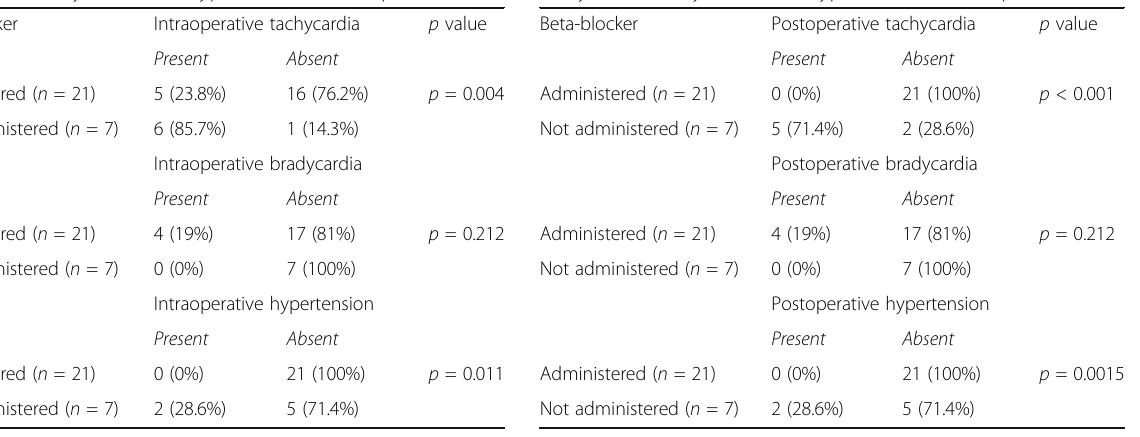
Table 3 Relation of use of beta-blocker with intraoperative tachycardia, bradycardia, and hypertension in GPU patients